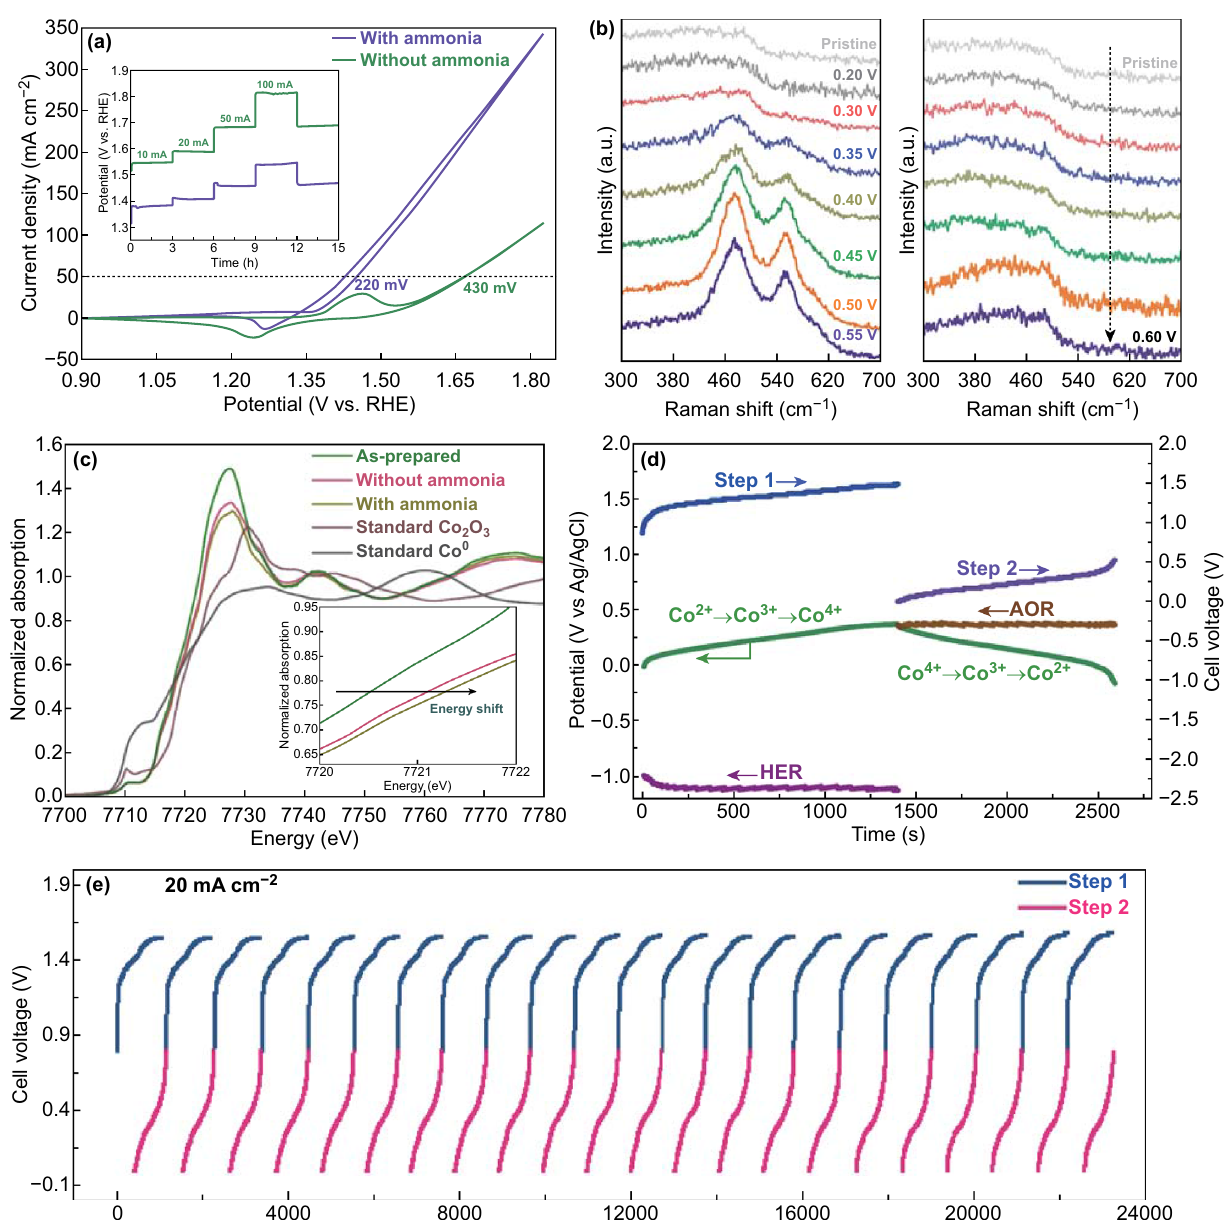
Fig. 5 a CV curves of NiSe in 1.0 M KOH with presence/absence of ammonia. (Multistep chronopotentiometric curves of NiSe/NF at differ‑ ent current densities are shown as insets.) b Raman spectra of the NiSe/NF as a function of potential in basic condition (left) and ammonia‑ containing solution (right). c In situ Co K‑edge XANES for Co 2 P/CoP NAs electrode recorded in various electrolytes. Experiments were carried out during potentiostatic process at the potential of 0.45 V versus Ag/AgCl. d Chronopotentiometry curve for reactor at a current density of 10 mA cm −2 , where the voltages for H 2 production (Step 1) and N 2 production (Step 2) are labeled by the blue and purple lines, respectively. Chronopotentiometry data (potential vs. time) of the HER electrode (crimson line), Co 2 P/CoP NAs electrode (green line) and AOR electrode (brown line) are provided. AOR denotes ammonia oxidation reaction. e Chronopotentiometry curves of H 2 /N 2 generation cycle at a current den‑ sity of 20 mA cm −2 . Chronopotentiometry data of step 1 (H 2 generation) and step 2 (N 2 generation) are labeled with blue and pink lines, respec‑ tively. (Color figure